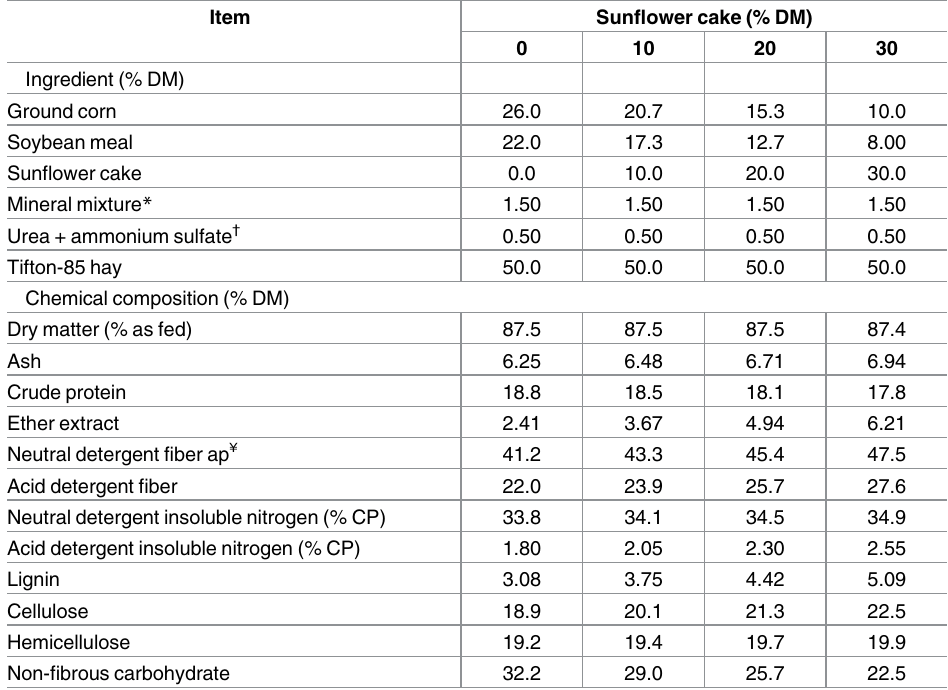
Table 1. Ingredient proportions and chemical composition of experimental